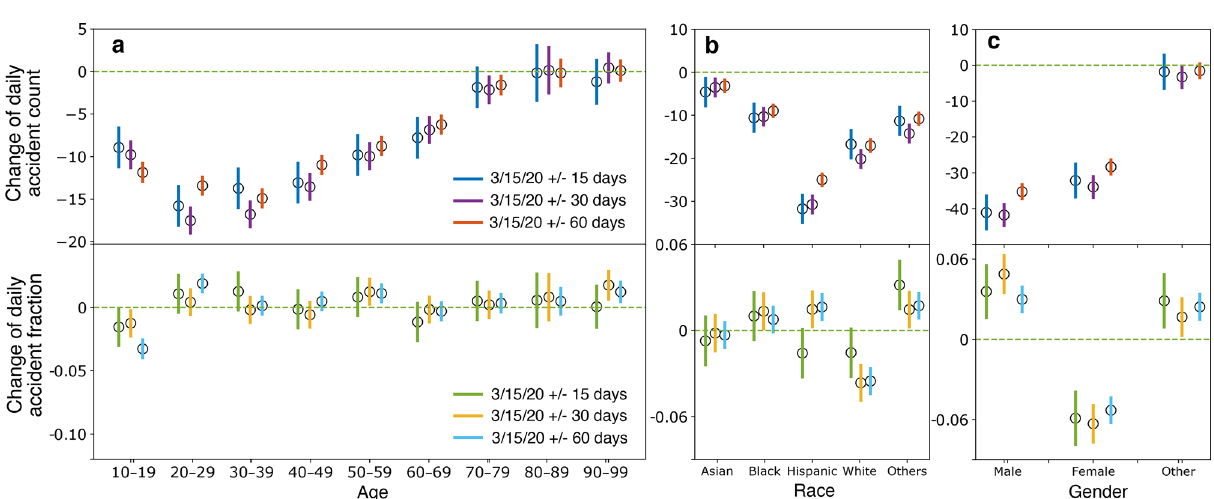
Figure 2. Change of daily accidents across age, race, and gender groups. Top: Change of daily accident count. Bottom: Change of daily accident fraction (the fraction of daily accidents among all accidents that day for each group). 95% confidence intervals are shown as vertical bars for each data point. Also shown are estimates from three time windows: 15 days (blue and green), 30 days (purple and orange), and 60 days (red and cyan) before and after the mobility